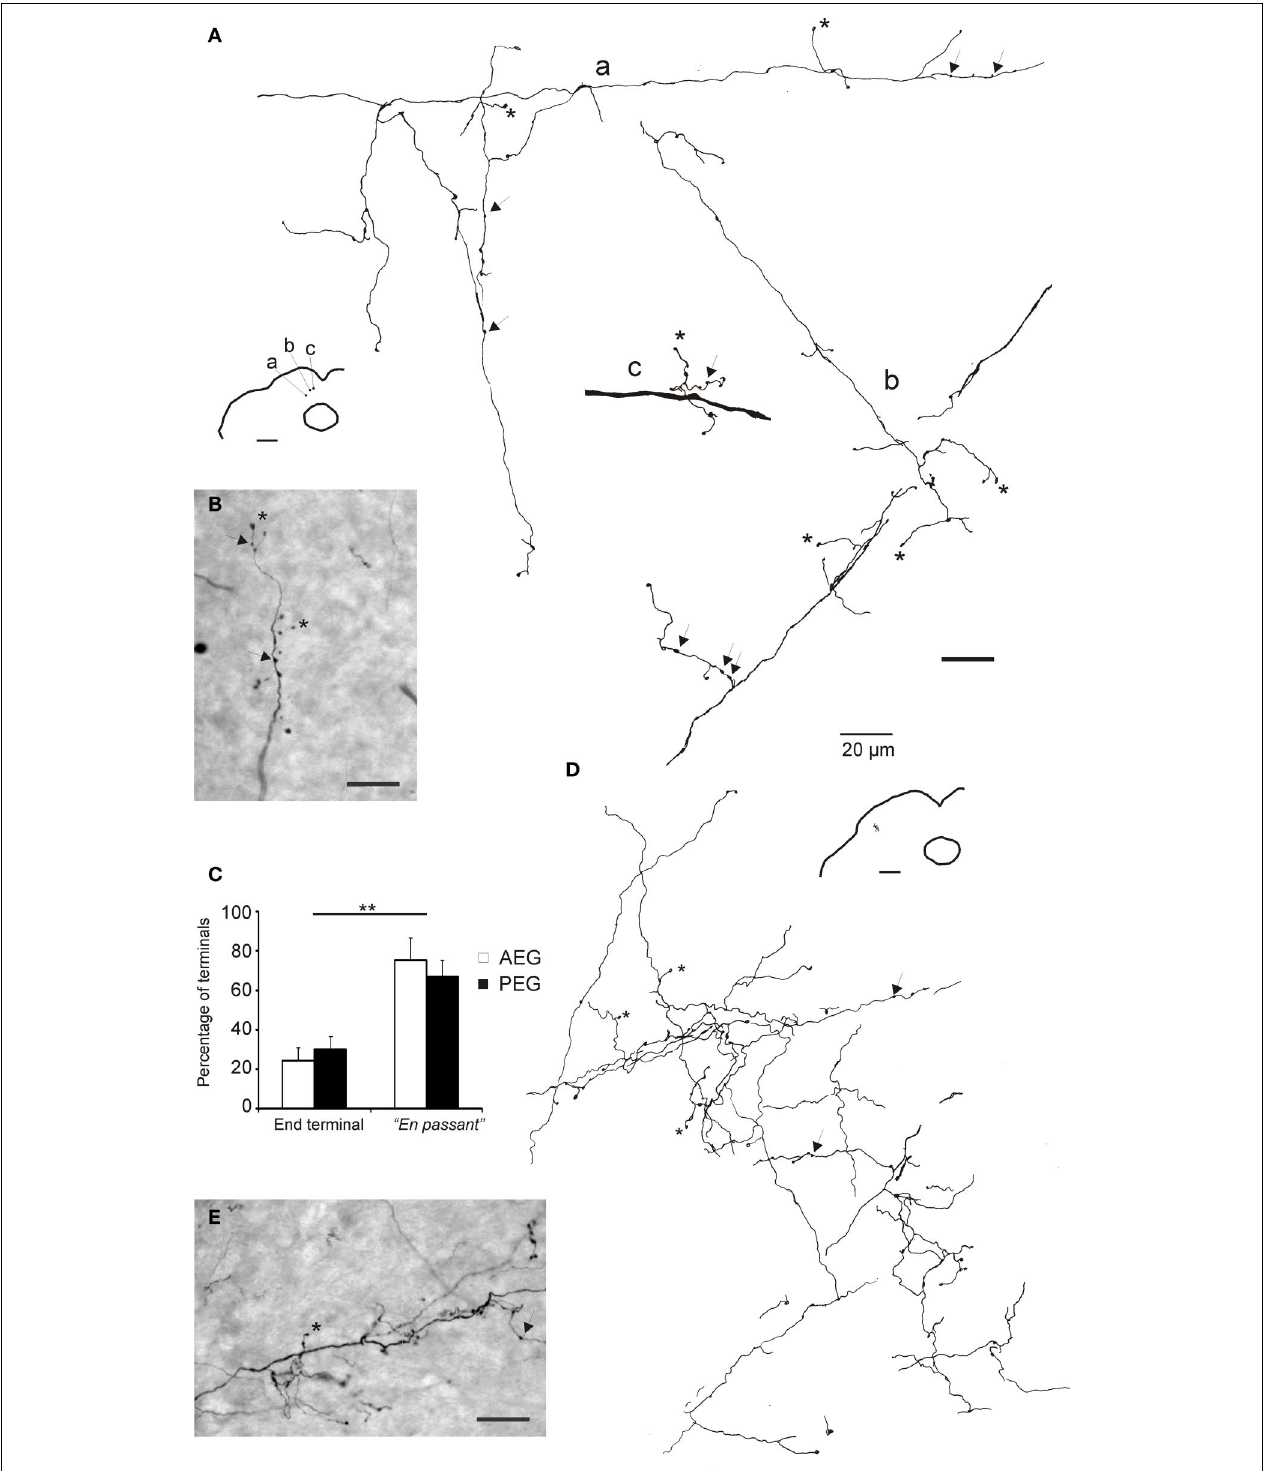
and en passant terminals with arrows. Calibration bars are 20 µm. (C) Histogram showing the percentage of the different types of terminals in the SC. En passant terminals were signifi cantly more numerous (** p < 0.001) than the end-terminals, irrespective of the location of the injection sites in the